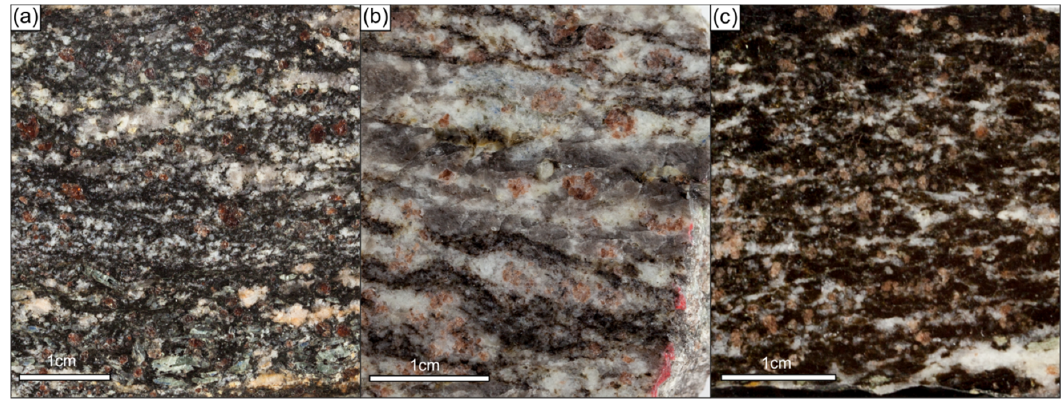
Figure 2. Photographs of the studied samples collected from the Marsfjället high-grade unit. ( a ) Kyanite- biotite-rich migmatitic paragneiss (sample MJ1805-A). ( b ) Quartz-rich migmatitic paragneiss (sample MJ1802-A). ( c ) Garnet amphibolite (sample MJ1801).